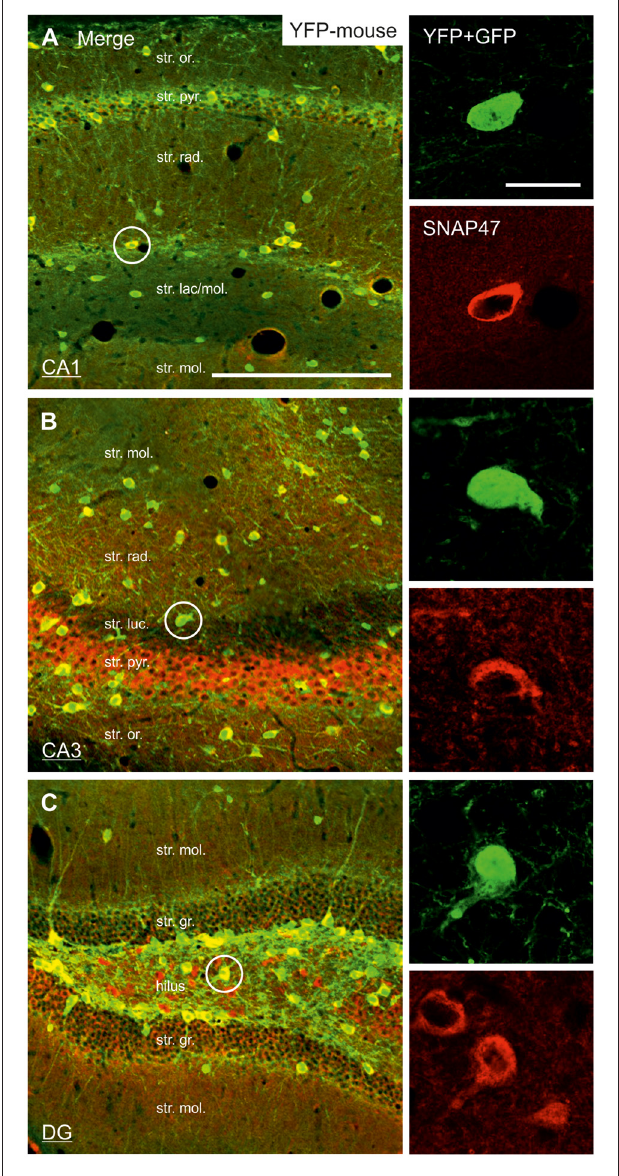
FIGURE 4 | Strong SNAP47 expression in YFP-positive INs in the hippocampus of VGAT-Venus(YFP) transgenic mice. (A–C) High-power confocal images of double immunolabeling for YFP and SNAP47 in the CA1 (A) , the CA3 areas (B) and the dentate gyrus (DG; C ) of VGAT-Venus(YFP) transgenic mice. Insets on the right show strong cytoplasmic localization of SNAP47 (red pseudocolor, bottom images) in YFP-positive cell bodies (green, top images). Scale bars represent, (A–C) , 250 µ m; insets, 20 µ m.